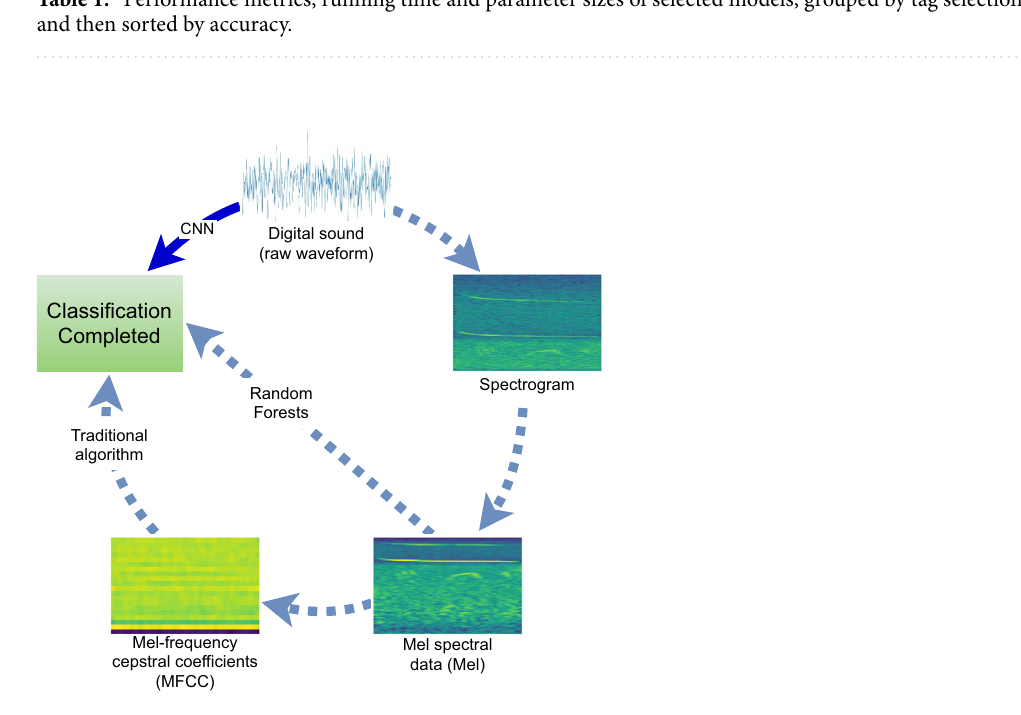
Figure 3. Sound Processing routine. A traditional approach requires four steps from sound to classification (clockwise). The MFCC step may be avoided when using Random Forests 19 . Future routines based only on CNN may process the sound directly (counterclockwise